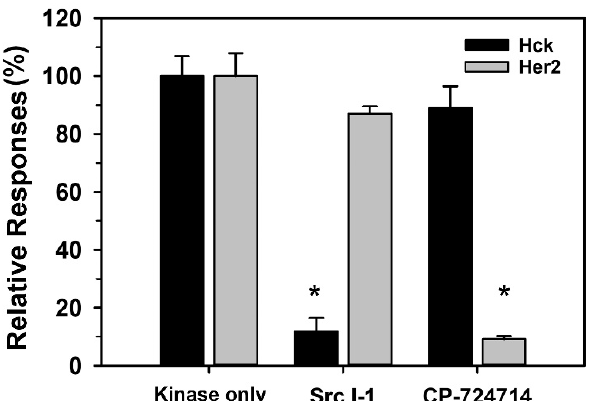
Figure 6. Effect of inhibitors on the activity of Hck and Her2 protein kinases. The phosphorylation reactions were performed in a kinase reaction mixture containing 10 U/mL of Hck (closed bar) or Her2 (open bar) and 100 μ M ELMO-Y511 (for Hck) or FLT3 (for Her2) with or without 176 nM Src-I1 or 20 nM CP-724714. After reaction, 2 µ L reaction mixture were subjected to electrochemical measurement on the sensing platform. The relative responses upon phosphorylation in the presence and absence of inhibitors were calculated and presented as the mean ± S.D of three independent experiments. (* denote significantly different from the activity of “kinase only” at p < 0.05).